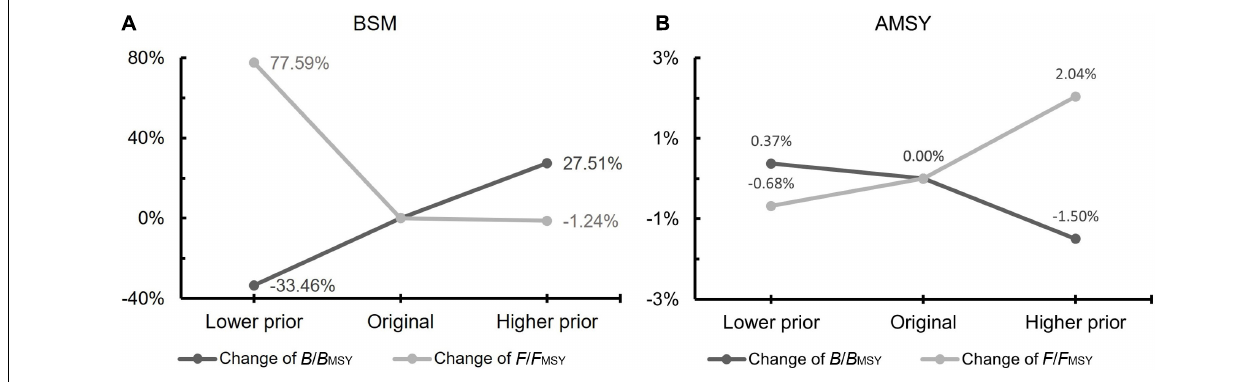
Frontiers in Marine Science |